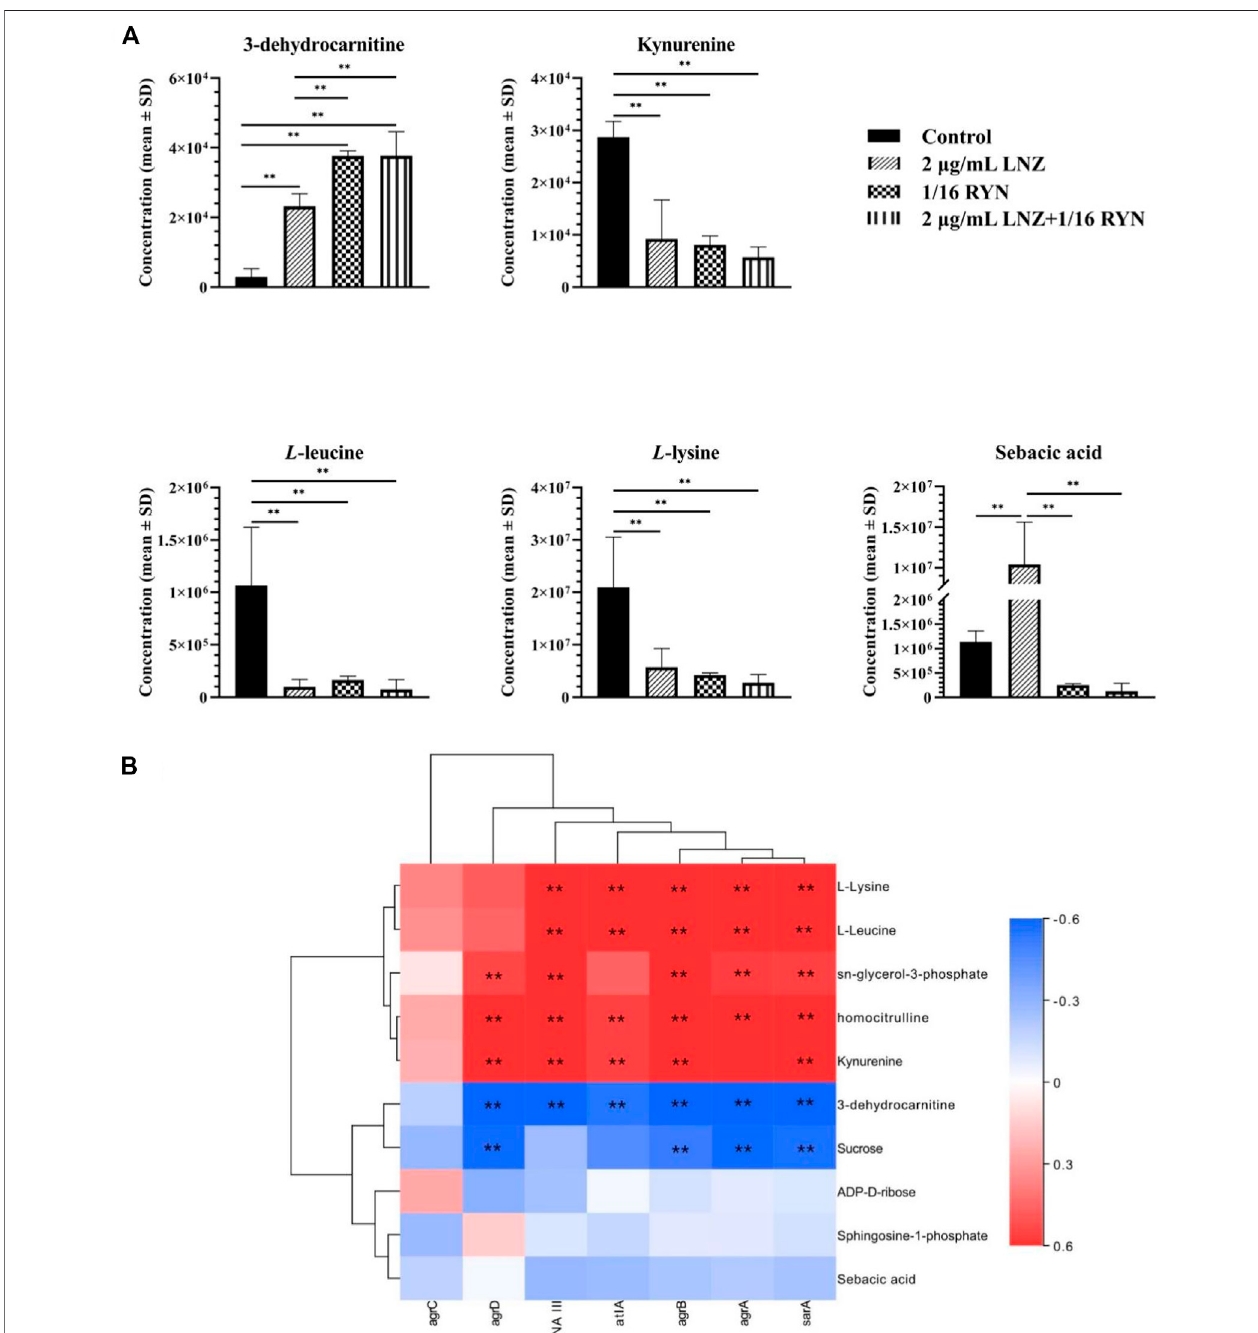
FIGURE 6 | Peak intensities of pharmacodynamic biomarkers in different groups and its correlation with gene expression. (A) ** p < 0.01. (B) Correlation analysis between pharmacodynamic biomarkers of RYN and LNZ and bio fi lm-associated genes. Signi fi cance levels are indicated as follows: ** p < 0.01, red and blue indicate positive and negative correlations,